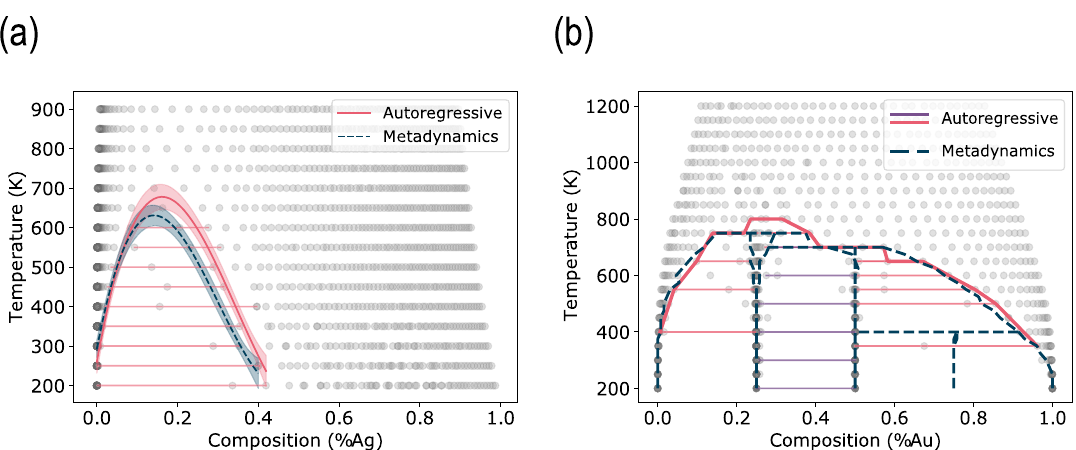
Fig. 5 Prediction of phase diagrams. SEGAL compared with metadynamics benchmark for ( a ) 125-site AgPd model and ( b ) 128-site AuCu model. For a , error bars are computed from the uncertainty on the polynomial fi t. For b , purple lines show the two-phase region for AuCu 3 and AuCu. Pink lines show the two-phase equilibria between ordered compounds and disordered solid